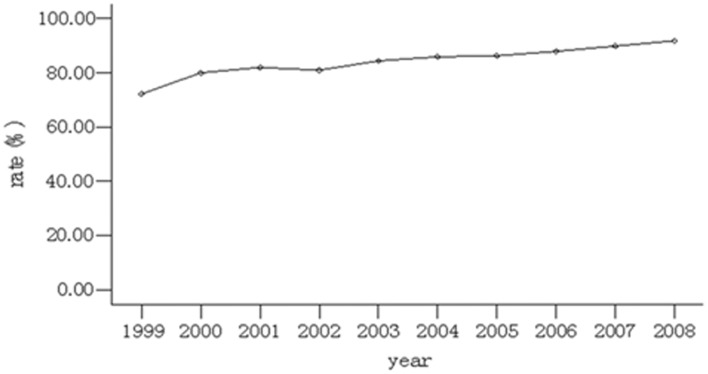
The trend of the use of hormone receptor testing during 1999 and 2008.